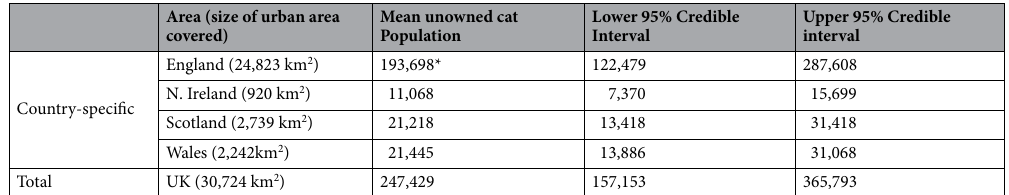
Table 1. Country-specific estimates of unowned cats and their 95% credible intervals, alongside a combined UK measure. *Estimates for England here are estimated using the standardised IMD quintiles to allow UK-wide estimates and are consequently different, although informatively similar, to the estimates that used the